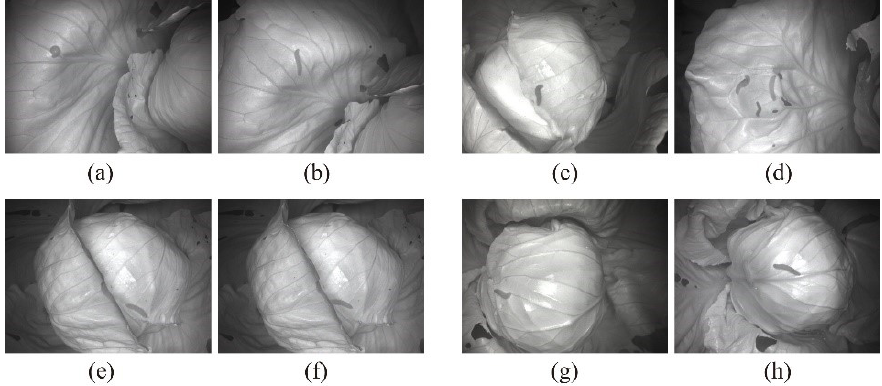
Figure 4. Pest images in different states. ( a ) Crouching pests, ( b ) Extended pest, ( c ) A pest, ( d ) Multiple pests, ( e ) Unobstructed pests, ( f ) Sheltered pests, ( g ) Pest on the left side of the image, ( h ) Pest in the middle of the image.